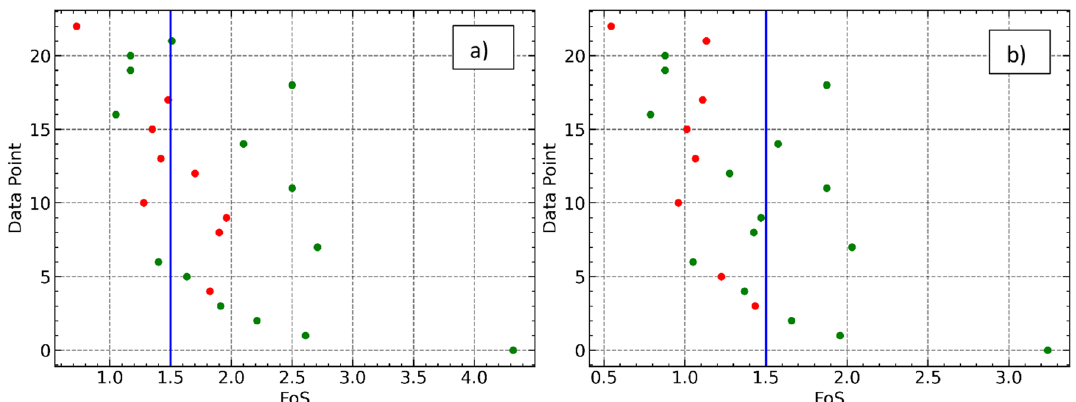
Fig. 10 Field validation scatter plots: a before rainfall parameter adjustment, b after rainfall parameter